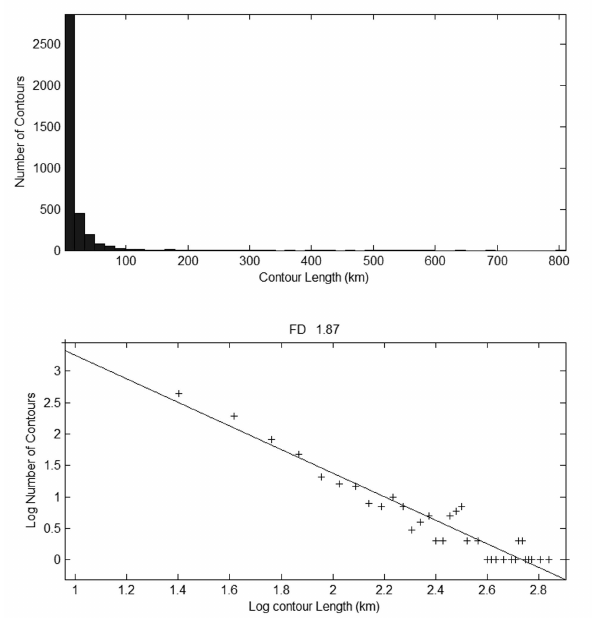
Fig. 2c, d. Histogram and log-log histogram of the lengths of the edge contours in Fig. 2b. A fitted power–law distribution is shown as a solid